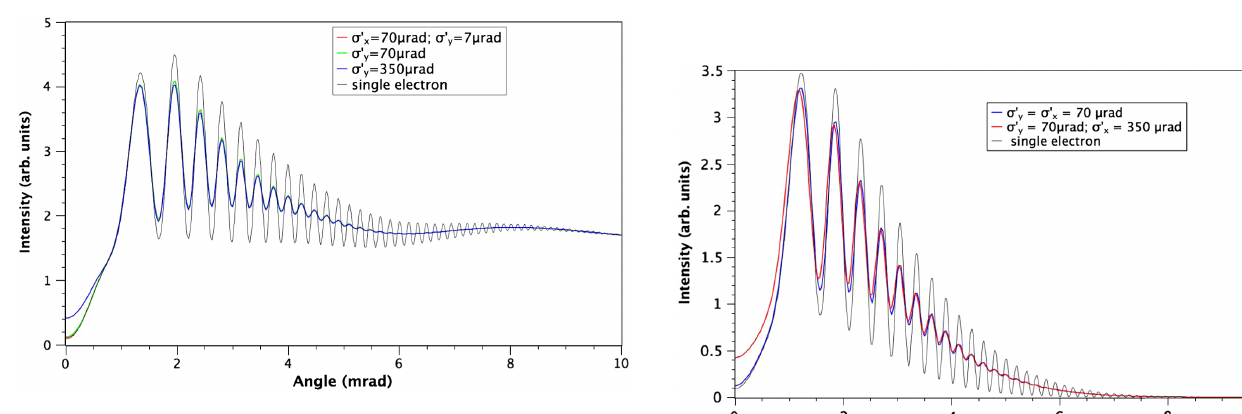
FIG. 13. Horizontal scan of OSRI from dipoles 2,3 for various values of horizontal ( x ) and vertical ( y ) divergences, along with single electron (zero divergence) scan ( E ¼ 286 MeV). The two curves corresponding to horizontal angular divergence of 70 μ rad (red and green) superimpose.